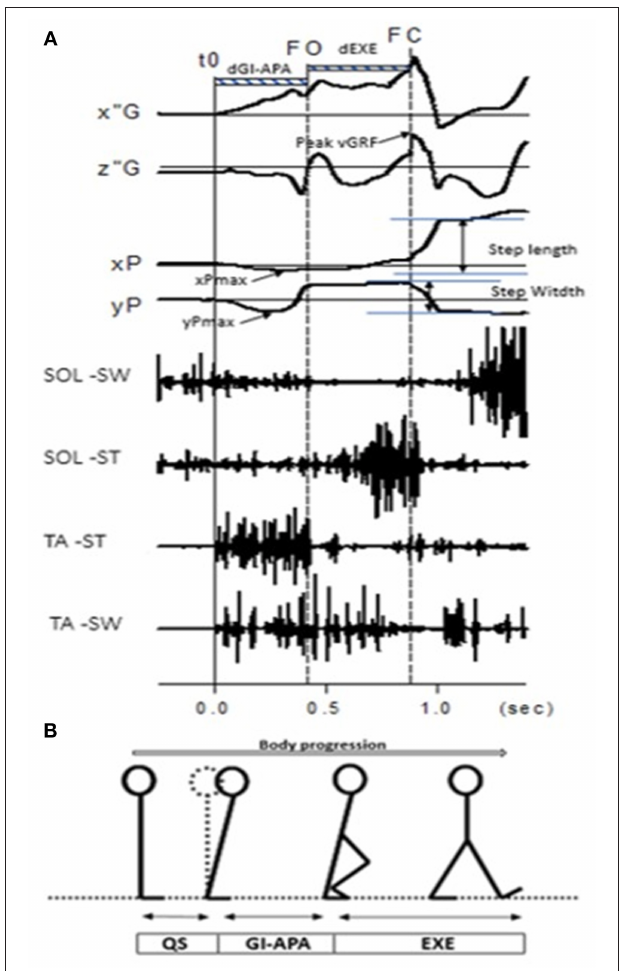
FIGURE 1 | (A) Example of biomechanical traces obtained for one representative normal subject initiating gait at a spontaneous velocity (one trial). Anteroposterior direction x”G: anteroposterior center of mass velocity; z”G: vertical center of mass velocity; peak vGRF: the maximal moment of vertical Ground Reaction Force; xP, Center of pressure (COP) displacement; xPmax: maximal backward shift of CoP. Mediolateral direction yP, mediolateral COP displacement; yPmax, maximal mediolateral shift of COP. Vertical lines, t0 onset variation of biomechanical traces; FO, Swing foot off; FC, Swing foot contact. FL, Foot lift. Horizontal dashed line: dGI-APA, duration of Gait Initiation-Anticipatory Postural Adjustments; d-EXE, duration of execution phase. SOL-SW, Soleus electromyographical activity of swing leg; SOL-ST, Soleus electromyographical activity of stance leg; TA-ST, Tibialis Anterior electromyographical activity of stance leg; TA-SW, Tibialis Anterior electromyographical activity of swing leg. (B) Stick representation of the different phases and temporal events of gait initiation in a normal subject. QS, quiet standing; GI-APA, gait initiation-anticipatory postural adjustments; EXE, execution